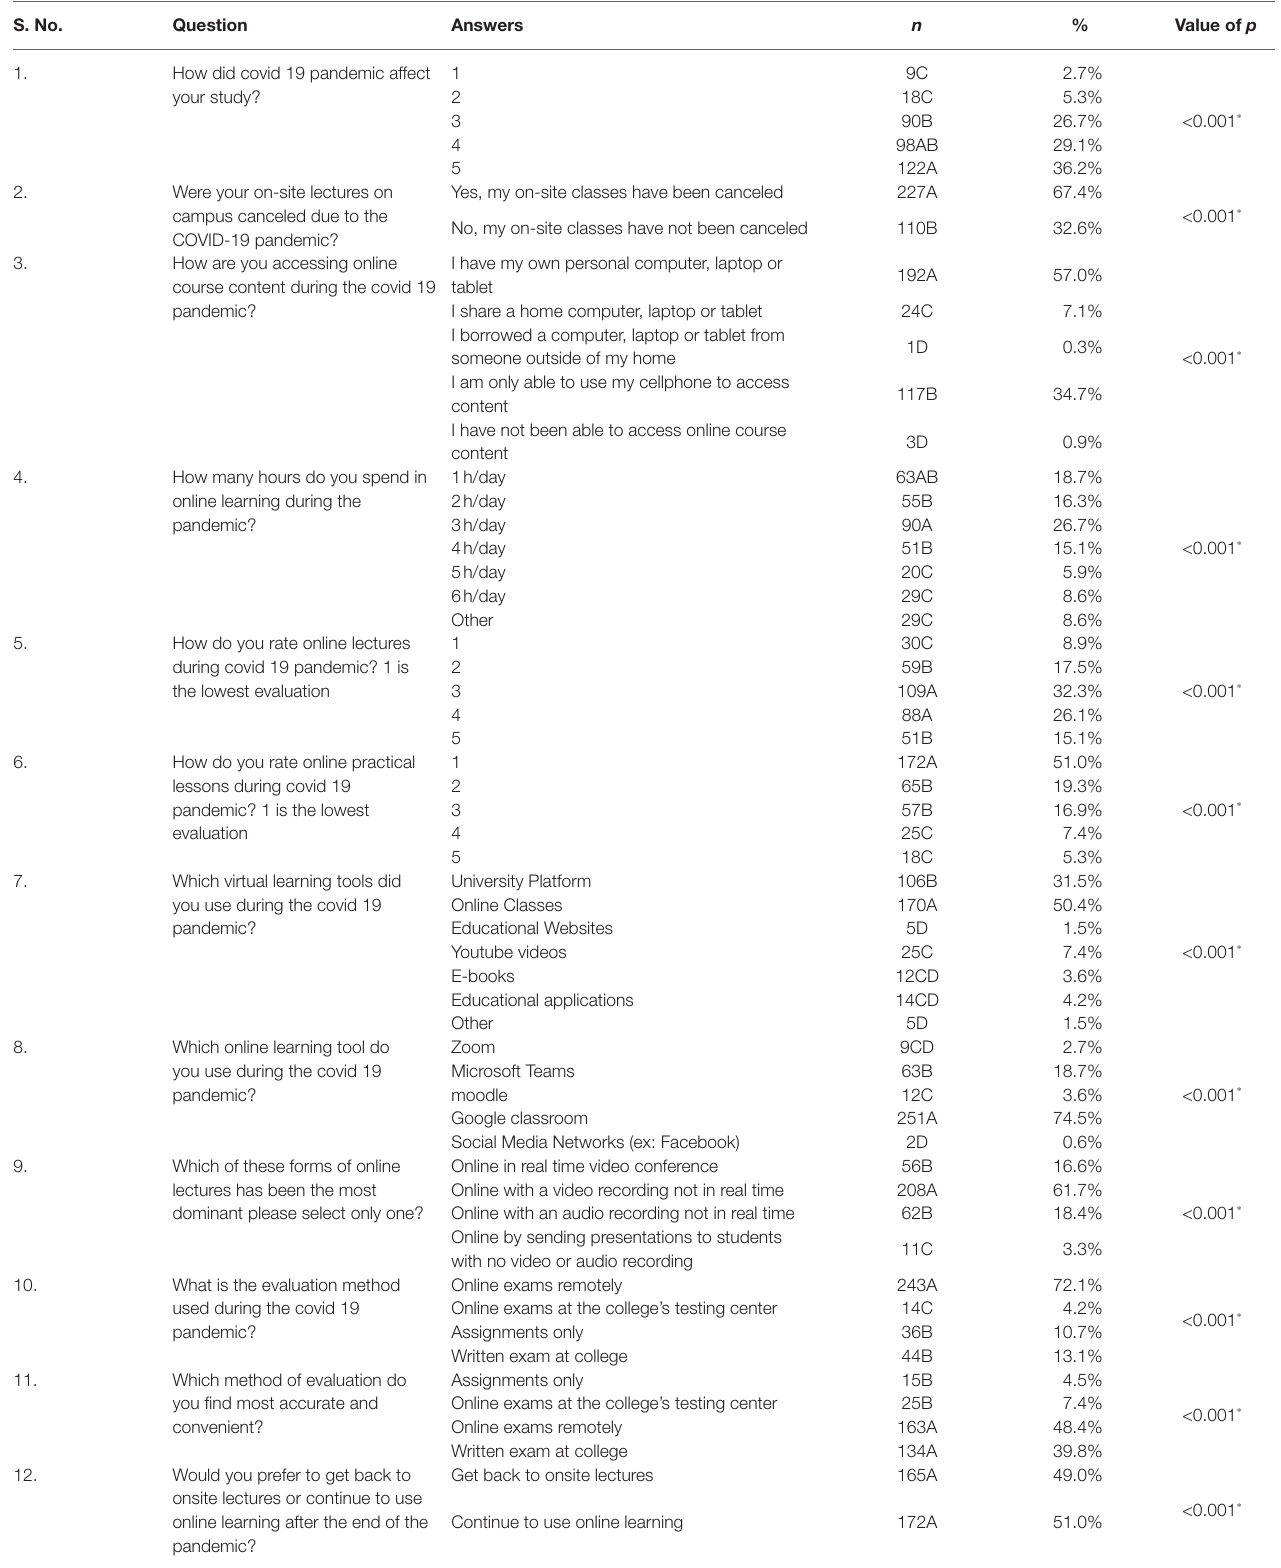
TABLE 2 | Frequency and percentage (%) for answers for assessing the impact of COVID-19 pandemic on the academic performance. S.